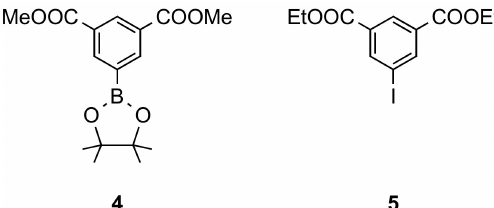
Figure 2. Necessary isophthalates 4 and 5 for the palladium catalyzed cross-coupling reactions to form hexadentate linkers 6 and 8